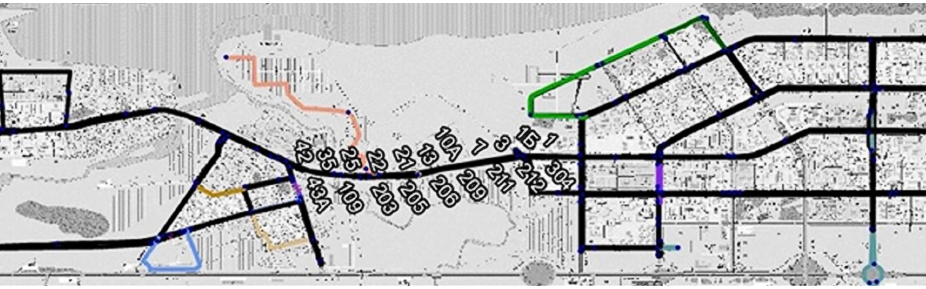
Figure 2. Scheme of the existing route network